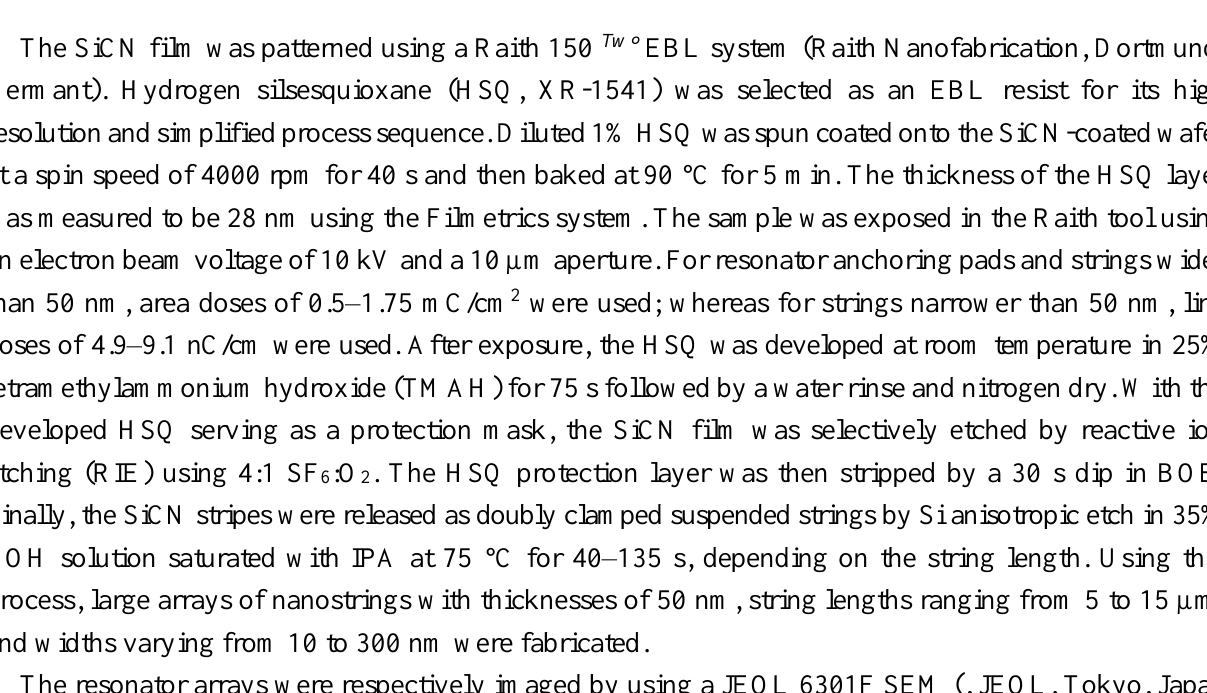
Figure 1. Process flow for the fabrication of SiCN